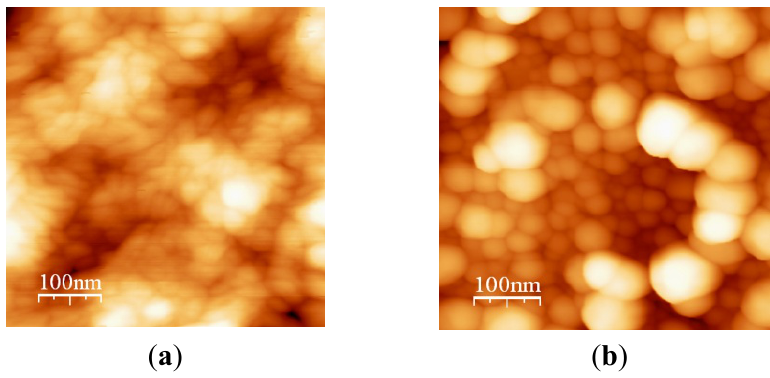
Figure 4. AFM image of Au-PTFE film 1 ( a ) T = 150 °C, size = 30–40 nm; ( b ) T = 220 °C, size = 60–80 nm.